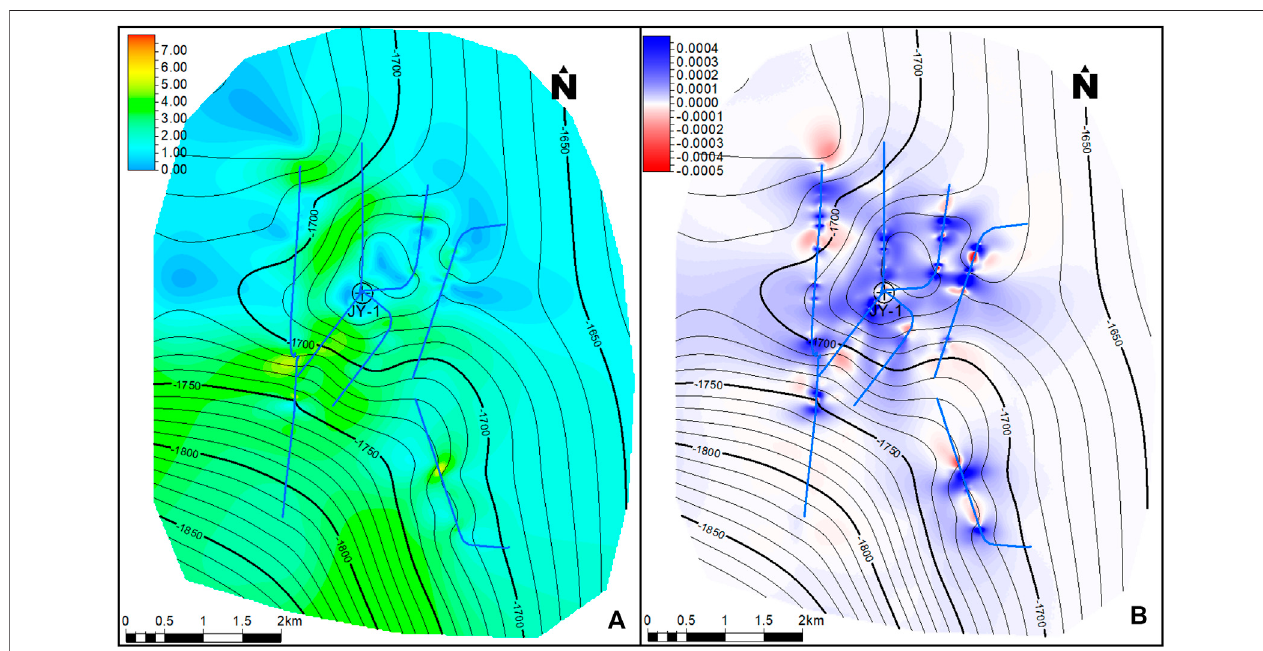
FIGURE 8 | The contour map of the dip angle (A) and curvature (B) of the Wufeng base surface that was made from the inferred formation top using shale layer TVTs from the vertical well JY-1.